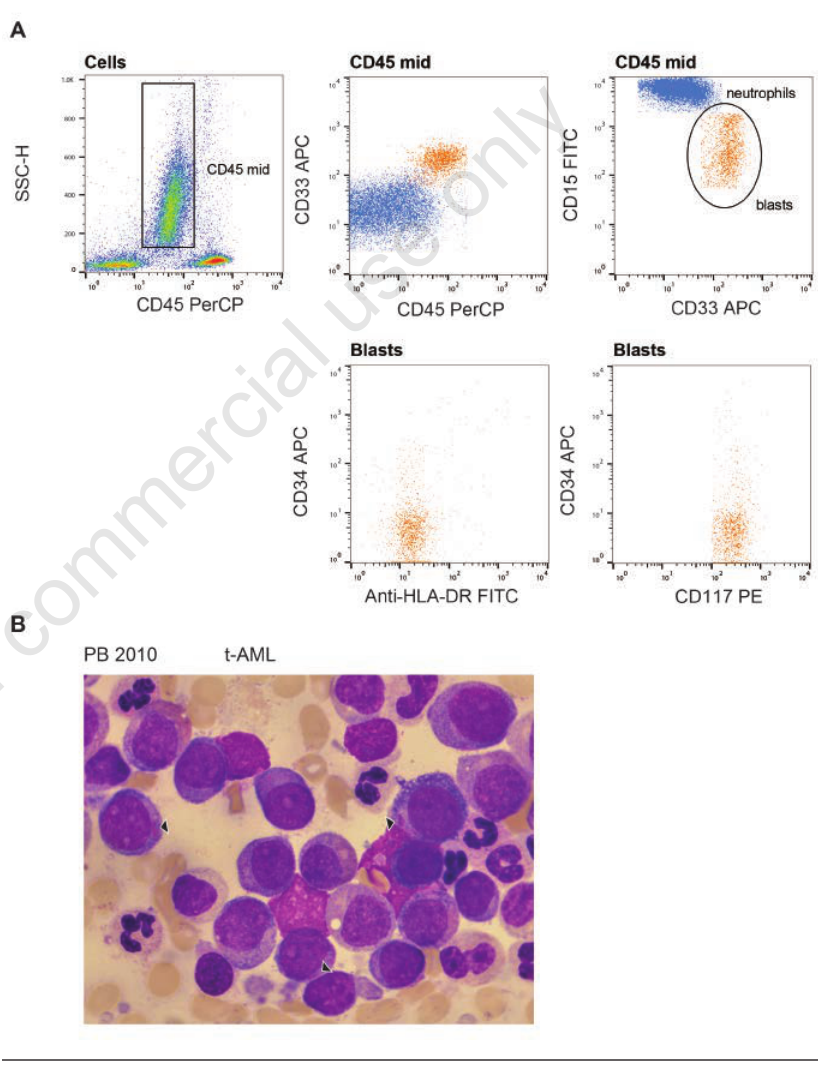
Figure 3. A) Flow cytometry analysis of bone marrow aspirate at time of t-AML diagnosis. Dot plots are depicted: the gated population is indicated on top of each dot plot. The CD45mid population was plotted against CD15 and CD33, and CD33 + CD15 mid aber- rant blasts (orange population in the dot plots) were further analyzed for expression of a series of markers, i.e. surface CD117, CD34 and HLA-DR. B) t-AML as observed in peripheral blood (PB) smear, showing increased intermediate-size blasts with a basophilic granular cytoplasm, some of them presenting Auer rods (arrowheads), (Hematoxylin & Eosin staining, magnification ×100). APL: acute promyelocytic leukemia; t-AML: therapy related acute myeloid